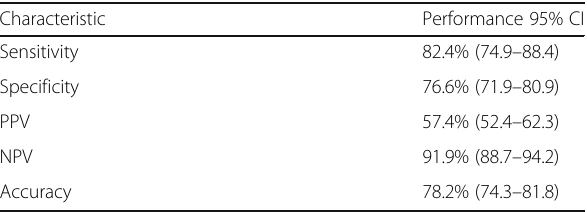
Table 3 RDT validity to diagnose Plasmodium falciparum malaria